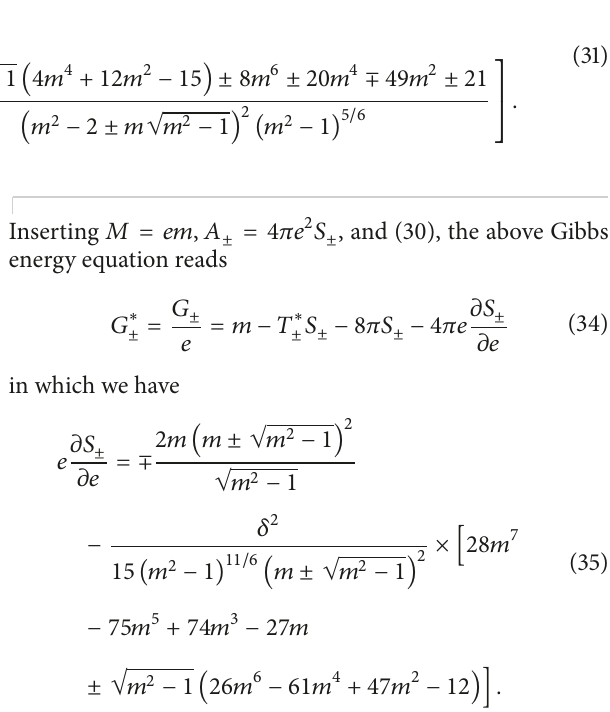
Figure 6. They show that 𝐺 ∗ − has minimum zero value at +∞ by decreasing 𝑚 󳨀→ 1 for 𝑚 = 1 but 𝐺 ∗ + raises to 󳨀→ ±∞ when 𝑚 󳨀→ 1. 𝛿 = 0.9. In case 𝛿 = 0 , we see 𝐺 ∗ ± Furthermore we plot diagrams of 𝐺 ∗ ± versus Δ𝑇 ∗ in Figure